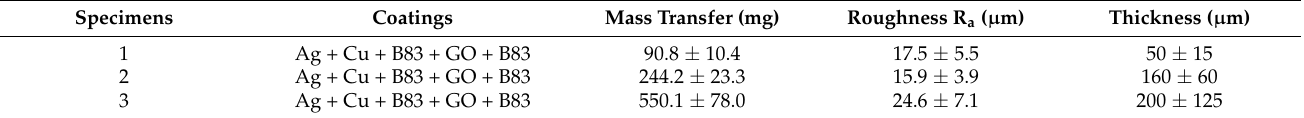
Table 2. The mass transfer, roughness, and thickness characteristics of the running-in